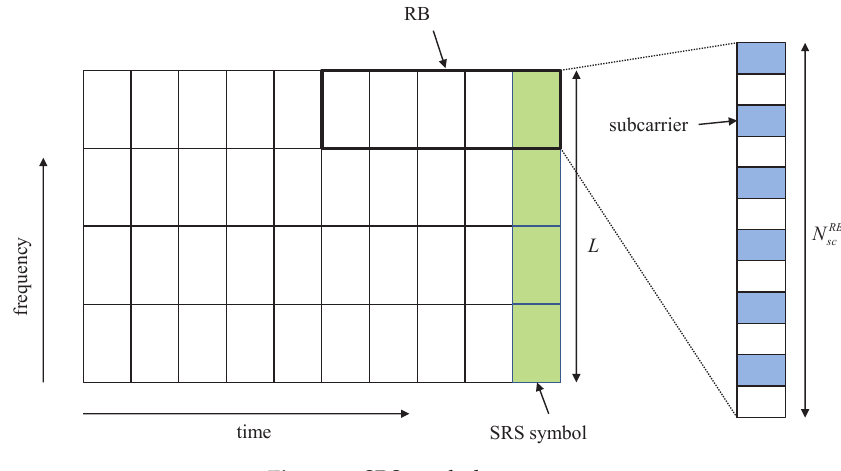
Figure 2. SRS symbol